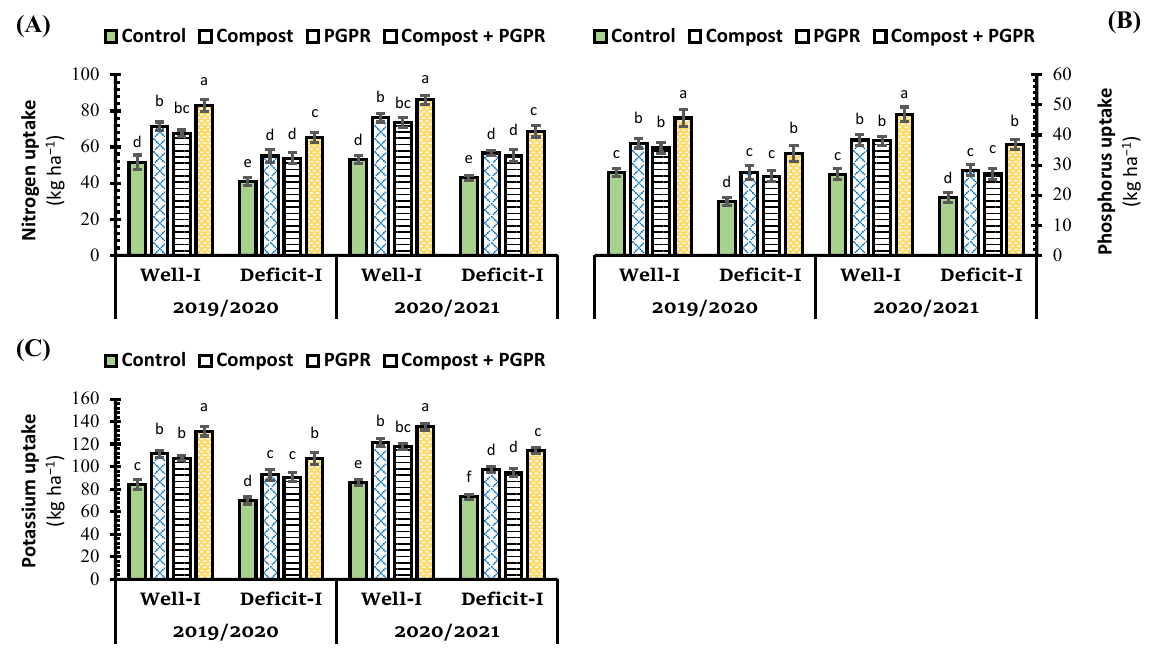
Figure 6. Influence of soil amendment with compost and plant growth-promoting rhizobacteria (PGPR) on the uptake of ( A ) nitrogen, ( B ) phosphorus, and ( C ) potassium by the grains of wheat plants grown in salt-affected soil and deficit irrigation in contrast to well irrigation. The error bars present the values of standard deviation. According to Duncan’s multiple range test, the same lower-case letters above columns are not significantly different ( p < 0.05).